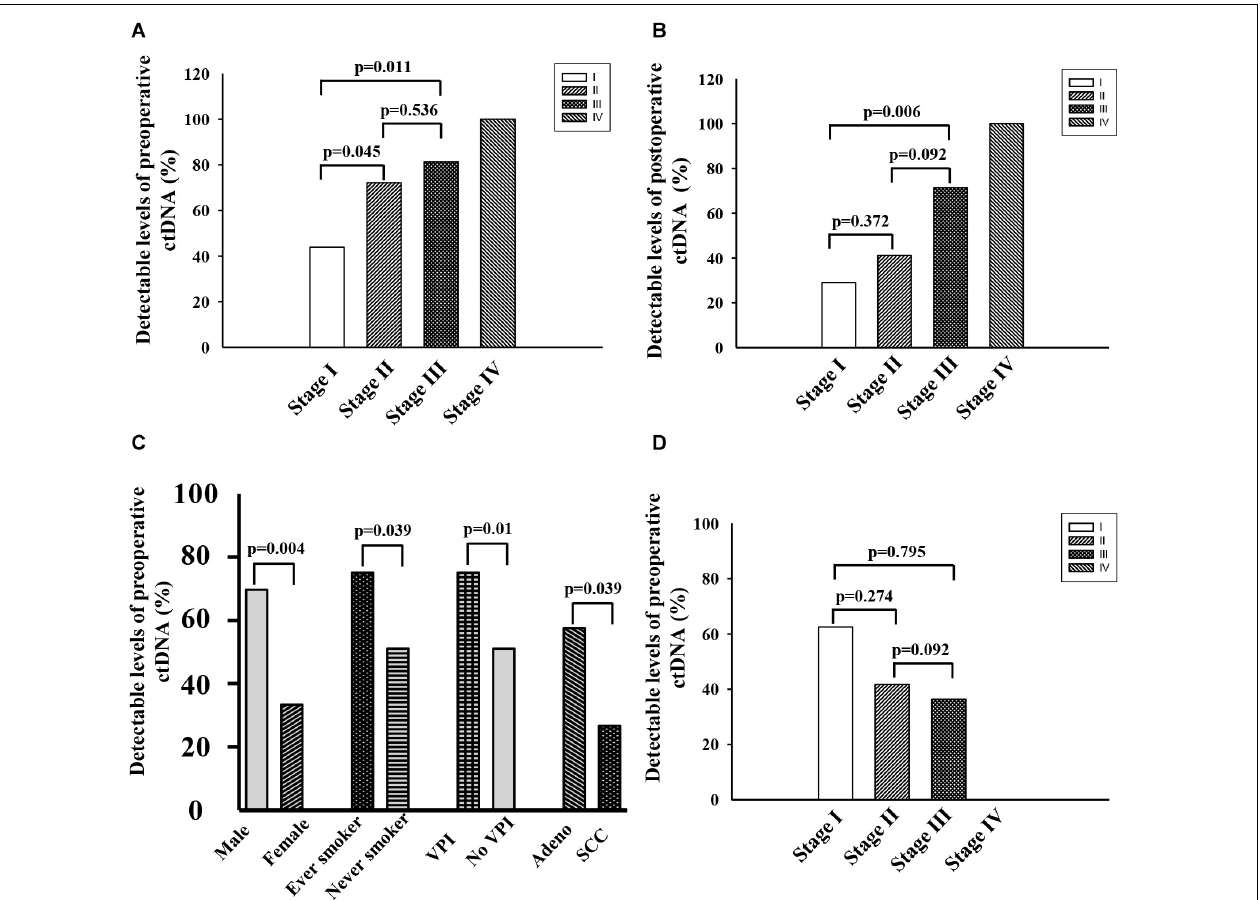
FIGURE 2 | (A) Fraction of patients with detectable preoperative ctDNA in NSCLC at cancer stage I ∼ IV. (B) Fraction of patients with detectable postoperative ctDNA in NSCLC at cancer stage I ∼ IV. (C) Characteristics associated with positive preoperative ctDNA. (D) Negative conversion ratio of preoperative ctDNA at cancer stage I ∼